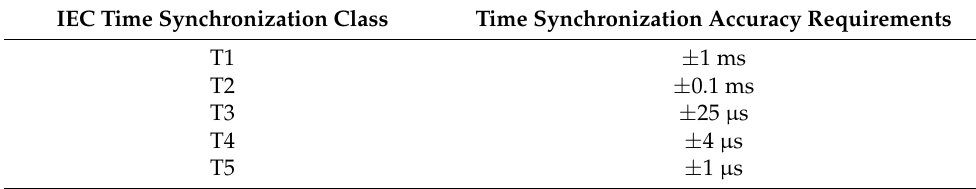
Table 1. IEC 61850 time synchronization class